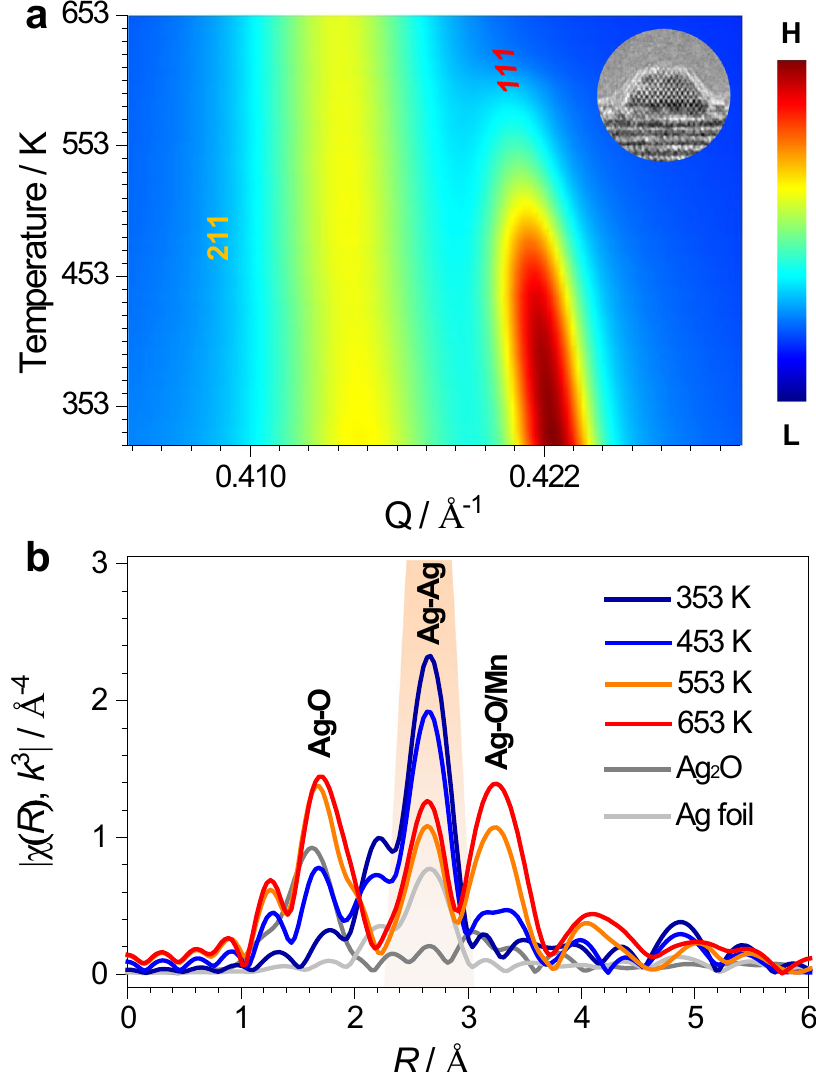
Fig. 3 Assembly process of ASWs. a Contour map of temperature-programmed SXRD patterns of Ag/MnO 2 as a function of momentum transfer (Q) from 323 to 653 K, showing the diffraction intensities of the Ag(111) and the α -MnO 2 (211) re fl ections. Inset: HRTEM image of Ag/MnO 2 with a Ag NP of 2 nm in height and 4 nm in width. H and L in the scale bar refer to High and Low in intensity, respectively. b Room-temperature ex situ Ag K -edge χ (R) k 3 - weighted FT EXAFS spectra of Ag/MnO 2 after being annealed at higher temperatures, and two references of Ag 2 O and Ag foil. The amplitudes of Ag 2 O, Ag foil, and Ag/MnO 2 spectra after being annealed at 353 K and 453 K were multiplied by 1/4, 1/18, 1/4, and 2/3,